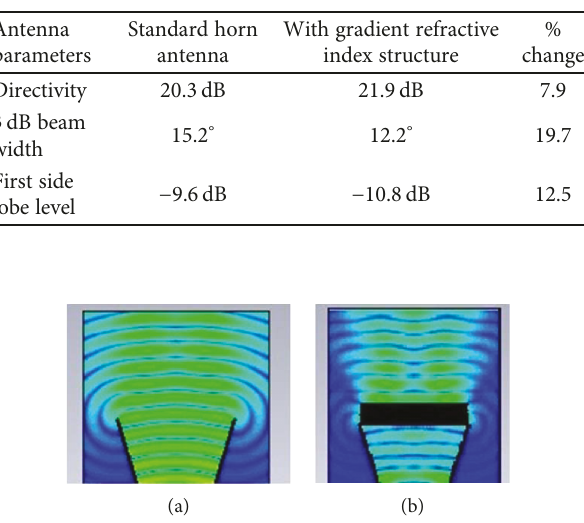
Table 1: Antenna parameters of the horn antenna with and without the gradient refractive index structure.